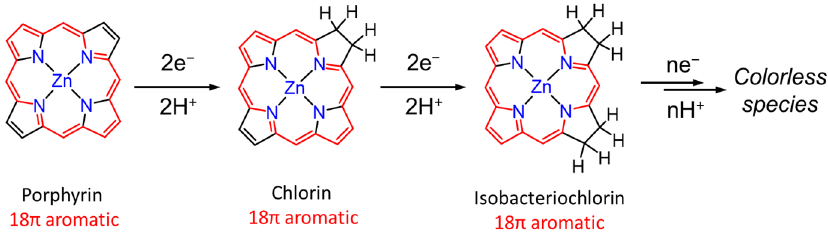
Figure 3. A decomposition process of Zn porphyrin during the photoreduction reaction [31].